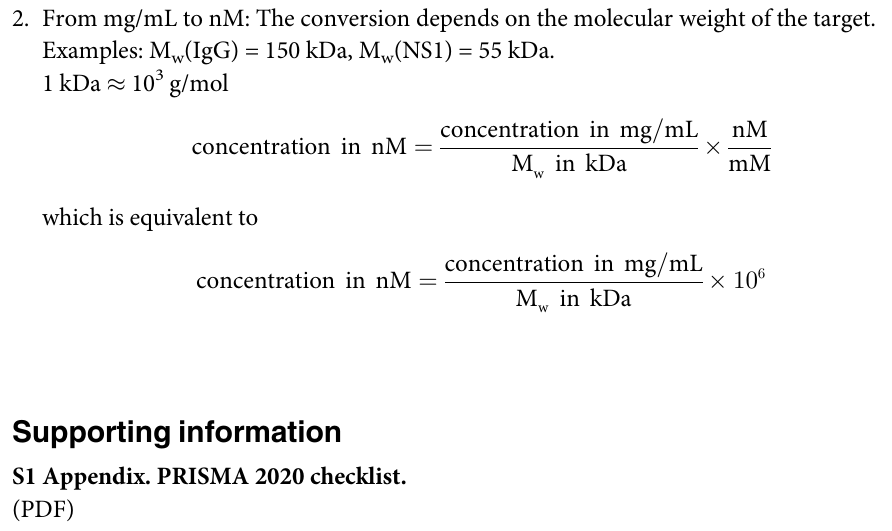
S1 Table. Data extracted from all papers selected for this